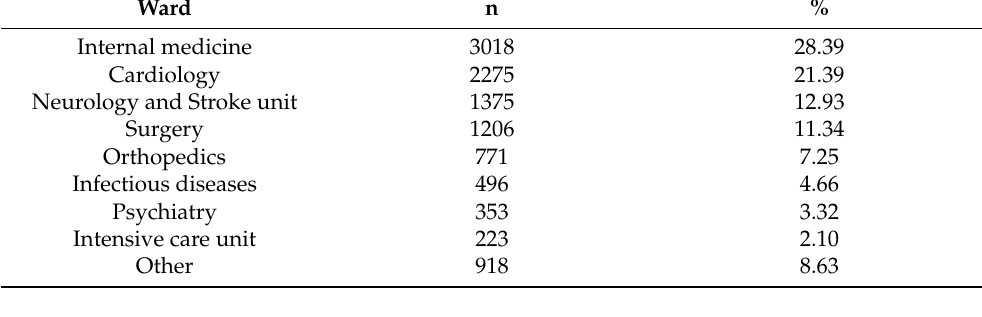
Table 1. The destination ward for admitted patients.